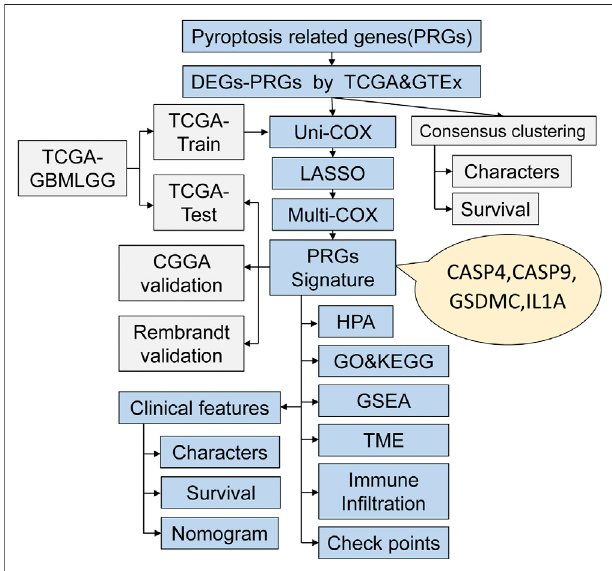
FIGURE 1 | The work fl ow chart of this study.